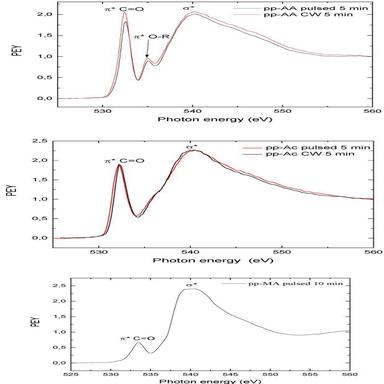
Oxygen NEXAFS spectra of pp-Ac, pp-AA, pp-MA prepared in optimal operating parameters.